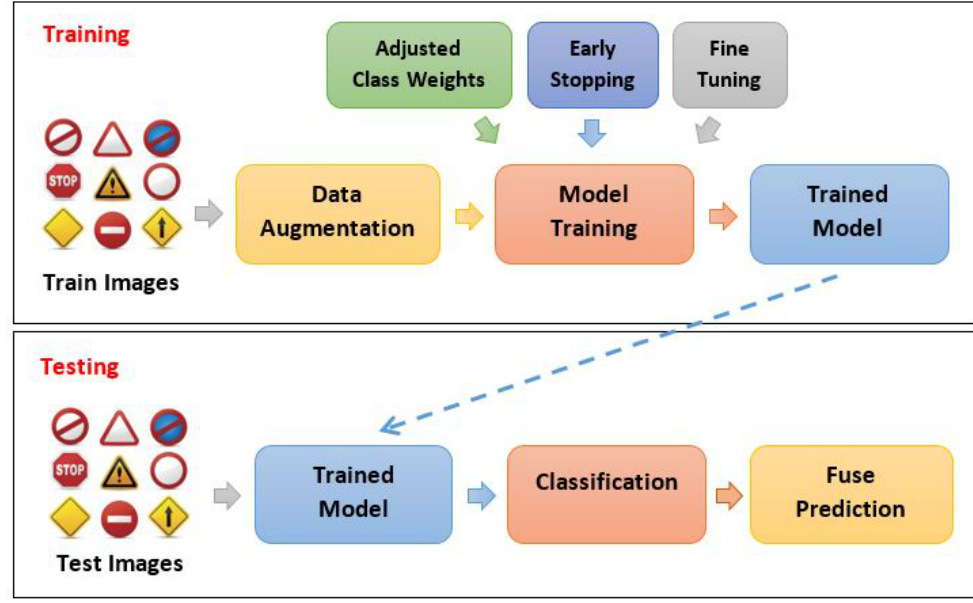
Figure 1. General pipeline of the proposed traffic sign